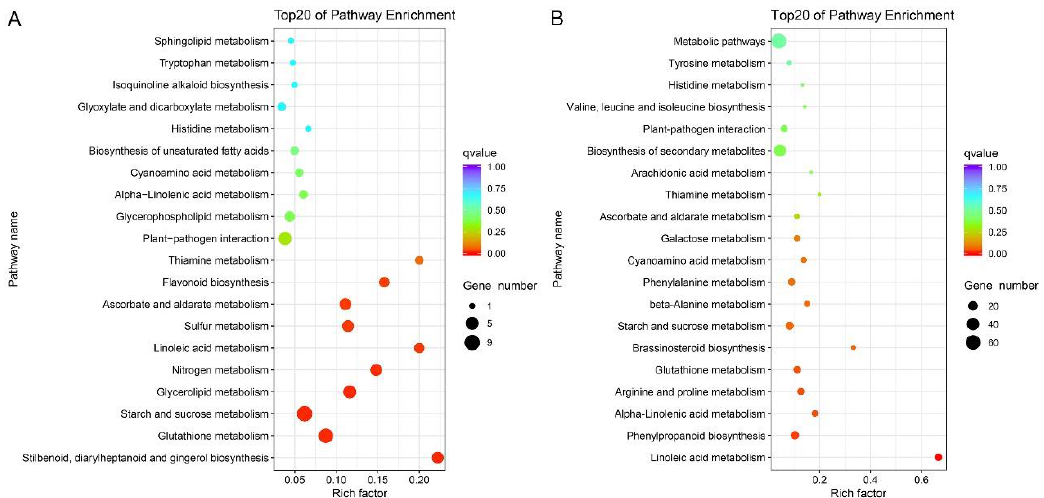
Figure 4. Top 20 Kyoto Encyclopedia of Genes and Genomes (KEGG) pathways in: B36 vs. A36 ( A ); and EB36 vs. EA36 ( B ). B36 vs. A36: Samples (seeds and seedlings) under N240 compared to those under N0 at 36 HAI. EB36 vs. EA36: Samples (only seedlings) under N240 compared to those under N0 at 36 HAI.